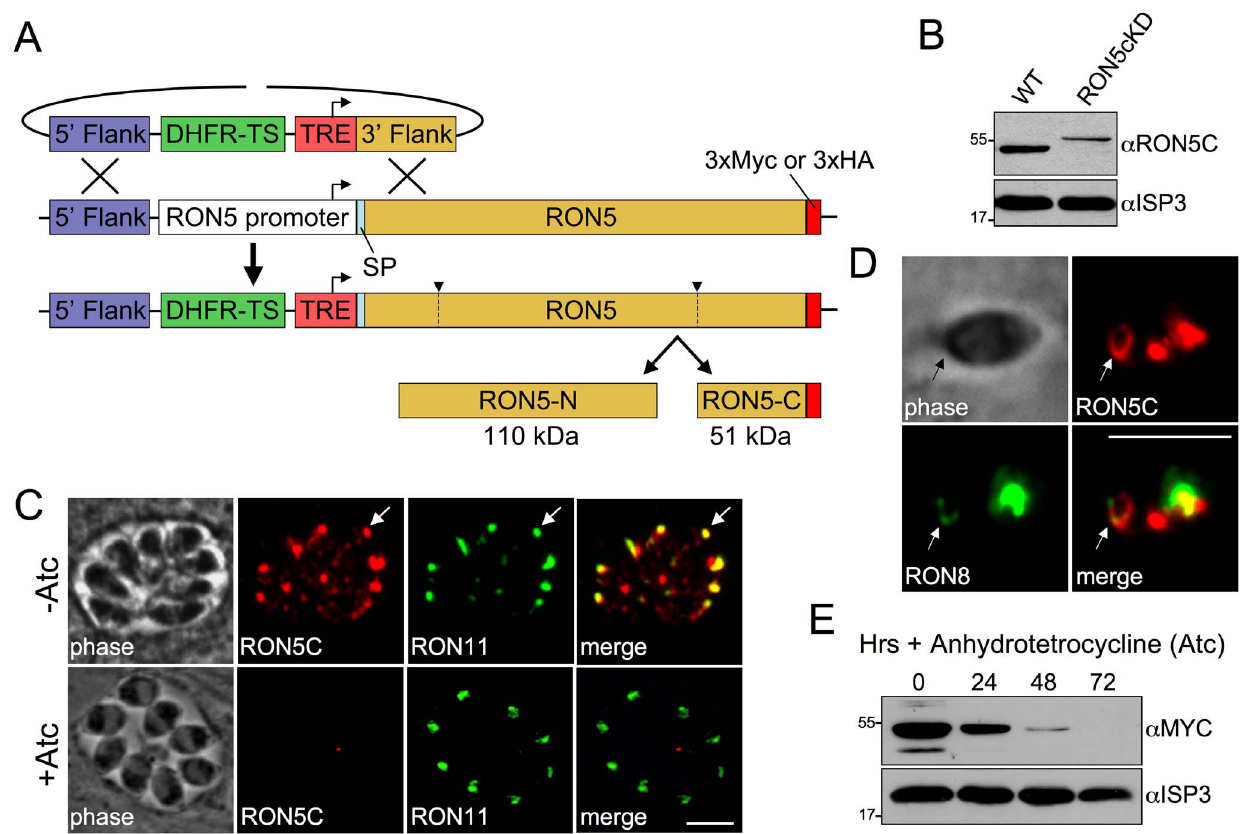
Figure 2. Establishment of a RON5 conditional knockdown mutant. (A) Strategy for generating RON5cKD parasites through direct replacement of the RON5 endogenous promoter with a tetracycline-repressible element (TRE) by homologous recombination. The TRE consists of seven tandem tetracycline operator sequences fused to a truncated SAG4 promoter. Prior to promoter exchange, a C-terminal endogenous 3xMYC or 3xHA tag was introduced at the C-terminus for improved detection. (B) Western blot comparing RON5C in wild-type and RON5 MYC cKD strains without Atc. Exchange of the endogenous RON5 promoter with the TRE results in lower levels of basal RON5 expression. As expected, an , 5 kD upshift in the RON5 MYC cKD strain corresponding to the endogenous 3xMYC tag is also observed. The IMC protein ISP3 serves as a loading control. (C) IFA of intracellular RON5 HA cKD parasites after 48 hours 2 / + Atc. Some mistargeting of RON5C is seen in untreated parasites due to the replacement of the endogenous, cell cycle regulated promoter with the constitutive SAG4 promoter in the TRE. A major focus of RON5 signal still colocalizes with RON11 in the rhoptry neck (arrows). No gross impact on the rhoptries is observed following depletion of RON5 as assessed by the non-MJ rhoptry neck protein RON11. Red: rabbit anti-HA antibody detected by Alexa594-anti-rabbit IgG. Green: rat anti-RON11 antibody detected by Alexa488-anti-rat IgG. (D) IFA of an invading RON5 HA cKD parasite. RON5C-3xHA signal is seen in the MJ (arrows) where it colocalizes with RON8. Red: rabbit anti-HA antibody detected by Alexa594-anti-rabbit IgG. Green: mouse anti-RON8 antibody detected by Alexa488-anti-mouse IgG. (E) Western blot showing RON5 levels in RON5 MYC cKD parasites after 24, 48 and 72 hours of Atc treatment. All scale bars=5 m m.